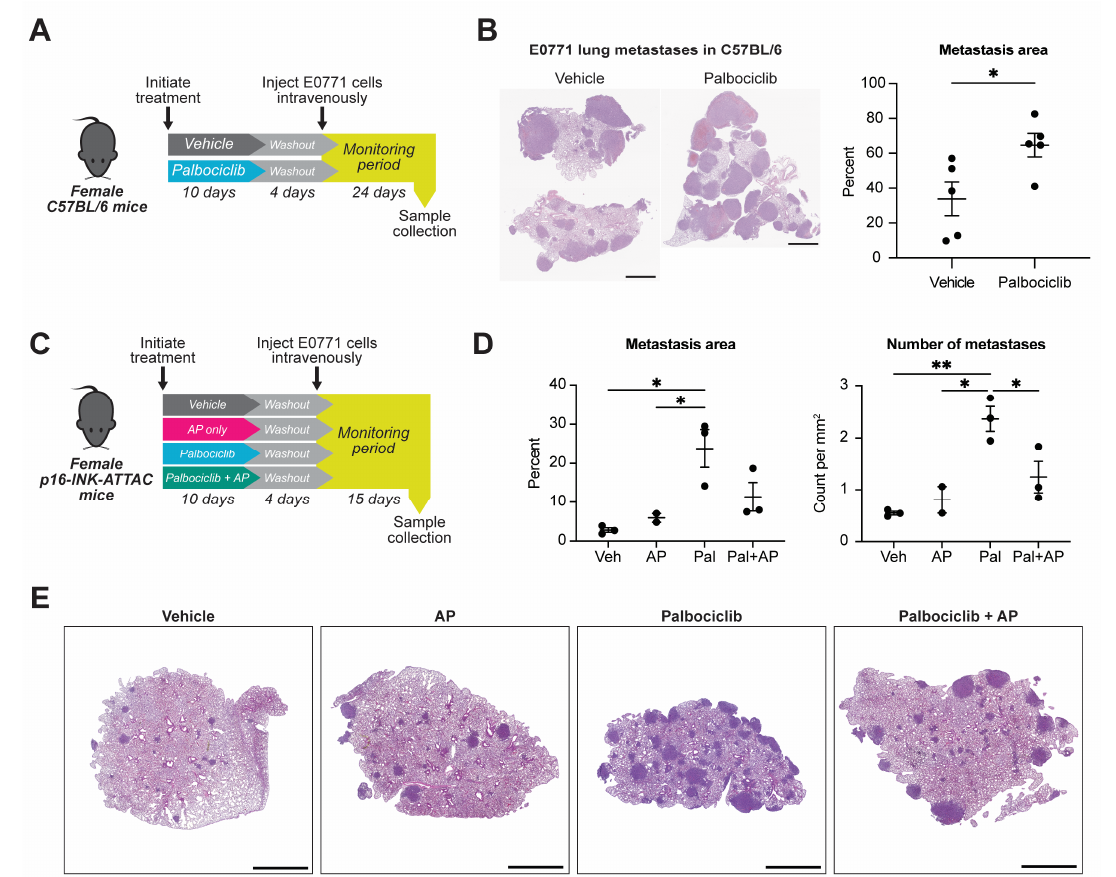
Figure 1. Elimination of senescent host stromal cells reduces palbociclib-enhanced seeding of E0771 TNBC cells in the mouse lung. ( A ) Experimental schematic: Female C57BL/6 mice received 10 days of 150 mg/kg palbociclib daily by oral gavage (10 doses) or vehicle, followed by a 96 h drug washout period and intravenous injection of 10 6 E0771 cells in the tail vein. Mice were then monitored for 24 days and euthanized. ( B ) Representative H&E-stained lung sections and quantification of cross-sectional lung area of histological section occupied by E0771 metastases from the design described in ( A ). n = 5 mice per group; mean ± standard error indicated. * p < 0.05 by unpaired t -test; scale bars 2 mm. ( C ) Experimental schematic: Female ATTAC mice received 10 days of 150 mg/kg palbociclib daily by oral gavage (10 total doses), AP20187 (AP) 2 mg/kg every three days by intraperitoneal injection (four total doses), and both palbociclib and AP or vehicle control throughout, followed by a 96 h drug washout period and injection of 10 6 E0771 cells intravenously in the tail vein. Following injection, mice were monitored for 15 days and then euthanized. ( D ) Quantification of E0771 metastases as a percentage of cross-sectional lung area on histological section and as a count of metastatic foci per mm 2 of lung area. Veh = vehicle ( n = 3 mice), AP = AP20187 ( n = 2 mice), Pal = palbociclib ( n = 3 mice), Pal + AP = combination treatment ( n = 3 mice); compared by one-way ANOVA with Tukey’s multiple comparisons test: * p < 0.05; ** p < 0.01. ( E ) Representative H&E-stained lung sections from experiment described in ( C ); scale bars 2